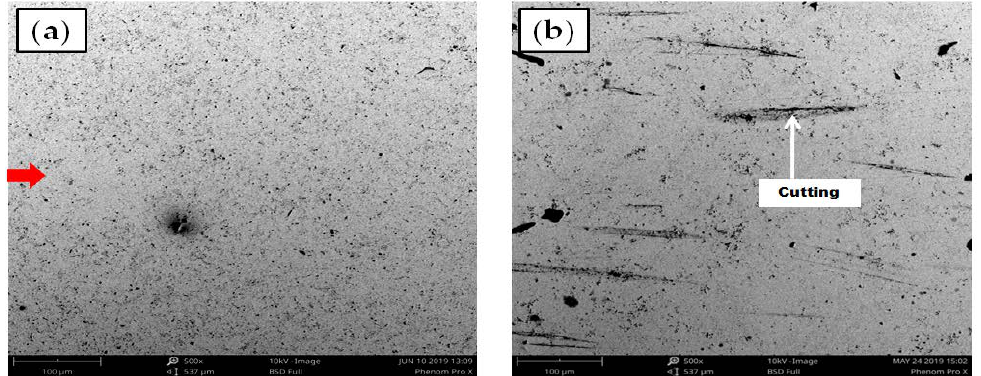
Figure 16. Microscopic images of 90-degree elbow BH section after the test at 0.5 m/s flow velocity ( a ) inlet ( b ) outlet.